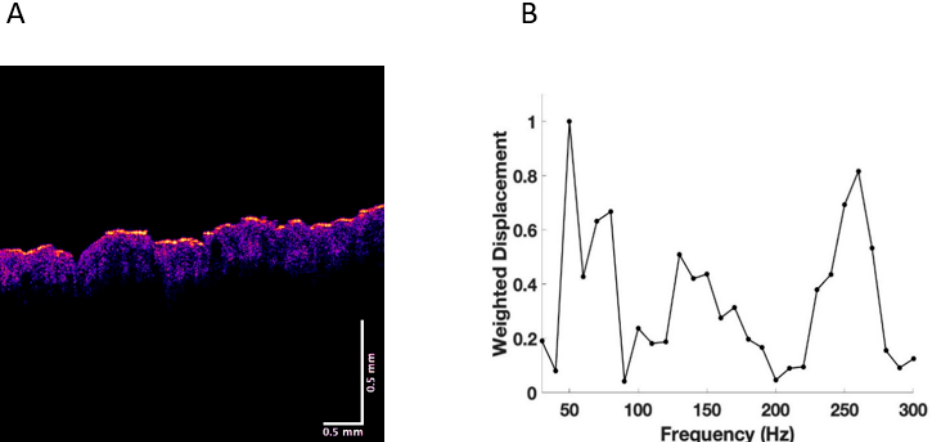
Figure 4. ( A ) Color-coded OCT image of a melanoma showing the paucity of epidermis (yellow and pink) and the papillary dermis in blue. Note: black spots show the location of the lesions. ( B ) Plot of weighted displacement versus frequency for SCC showing the new cellular (80 Hz), new vascular peak (130 Hz), and large fibrotic peak (250–260 Hz).